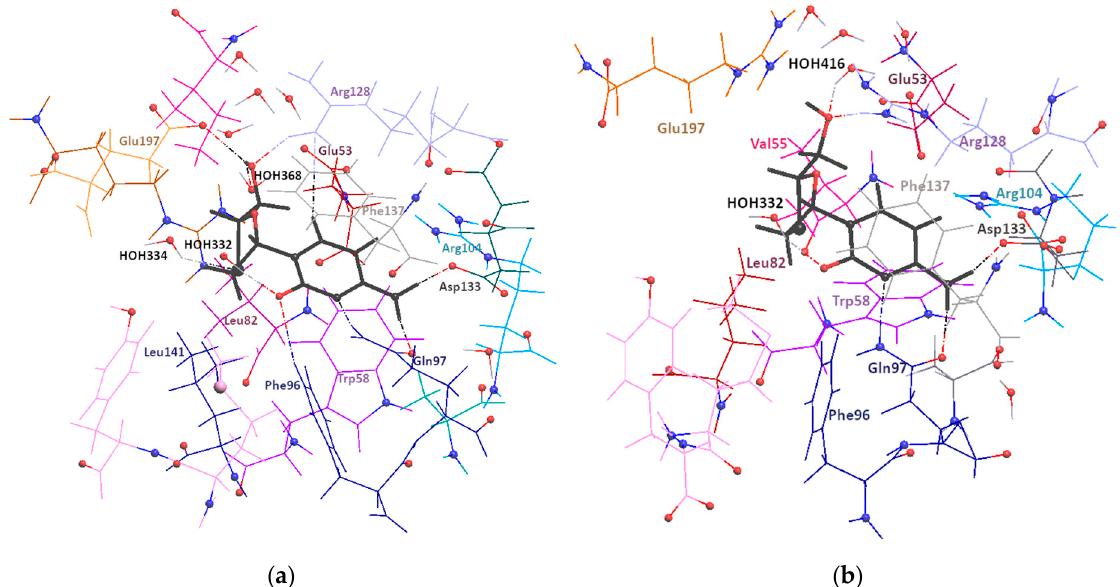
Figure 2. 3D representation of 3TC molecule surrounding in complexes ( a ) A and ( b ) B of 2NOA structure [31]. 3TC molecule is black, and different residues are marked with different colors. H- bonds are shown with dashed lines. Blue and red spheres correspond to nitrogen and oxygen atoms of receptor.